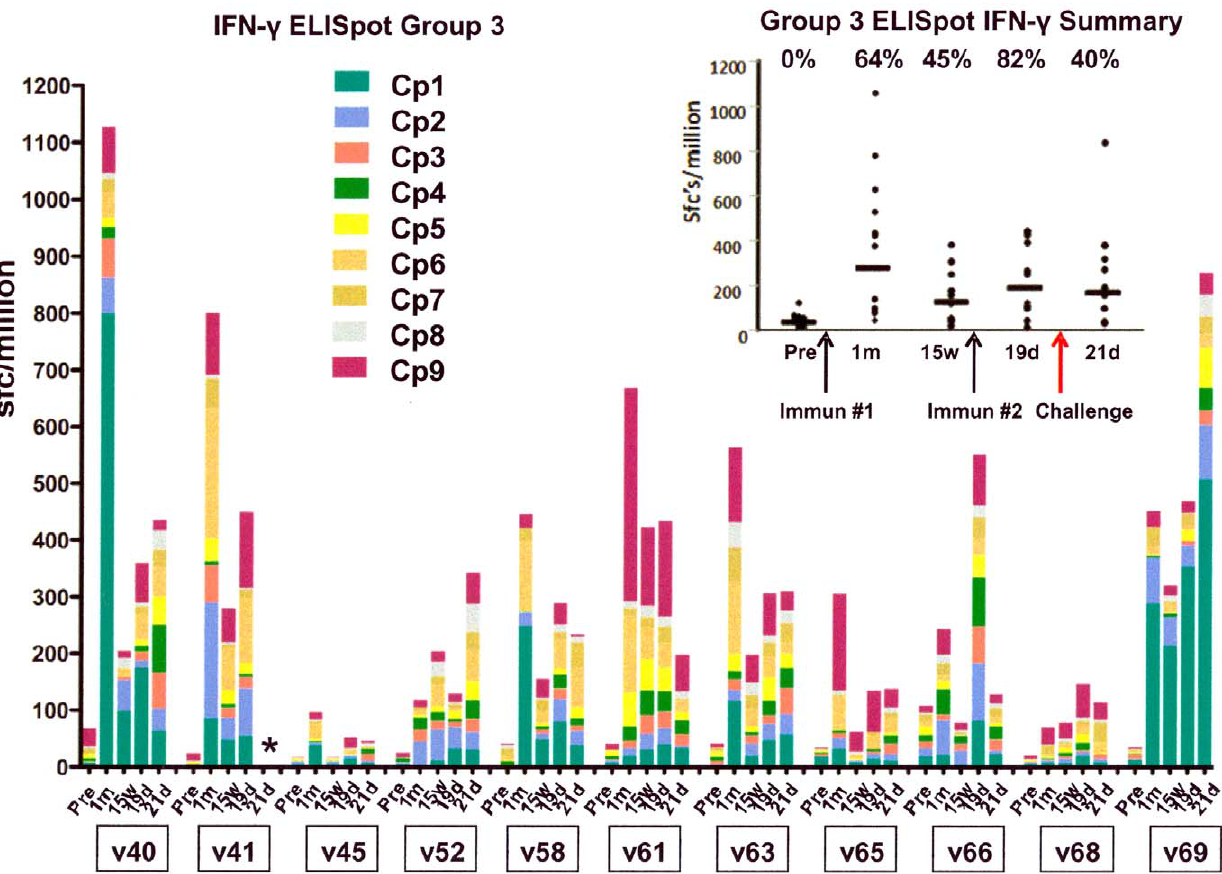
Figure 4. ELISpot IFN- c CSP. The ELISpot activity of each volunteer at pre-immunization, 1 month and 15 weeks after the first immunization, 19 days after the second immunization, and 21 days after challenge (* this last data point not available for volunteer 41), as stacked, color-coded peptide pool-specific responses at each time point. The insert shows the values of the sum of pool-specific responses for each volunteer at each time point. The horizontal bar indicates the geometric mean of the group, the arrows indicate the first and second immunizations and challenge, and the percent of volunteers who were positive with at least one CSP pool at each time point is written at the top of the insert.